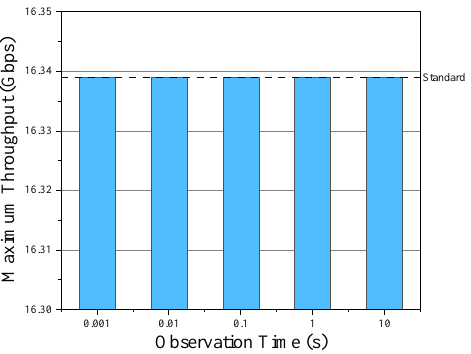
Figure 11. The maximum throughput rate of data plane at different observation